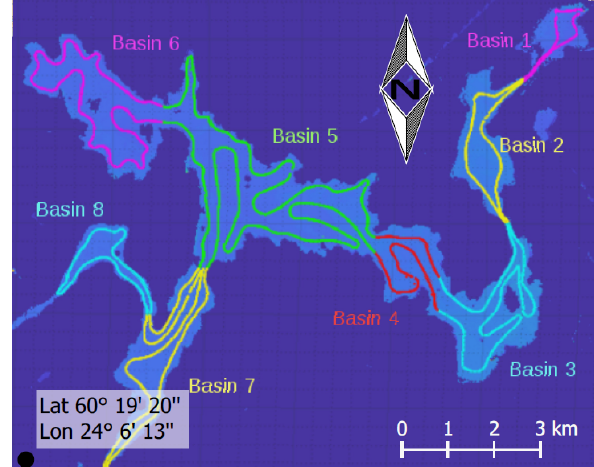
Figure 1. Lake Hiidenvesi divided into basins and the route of the reference measuring